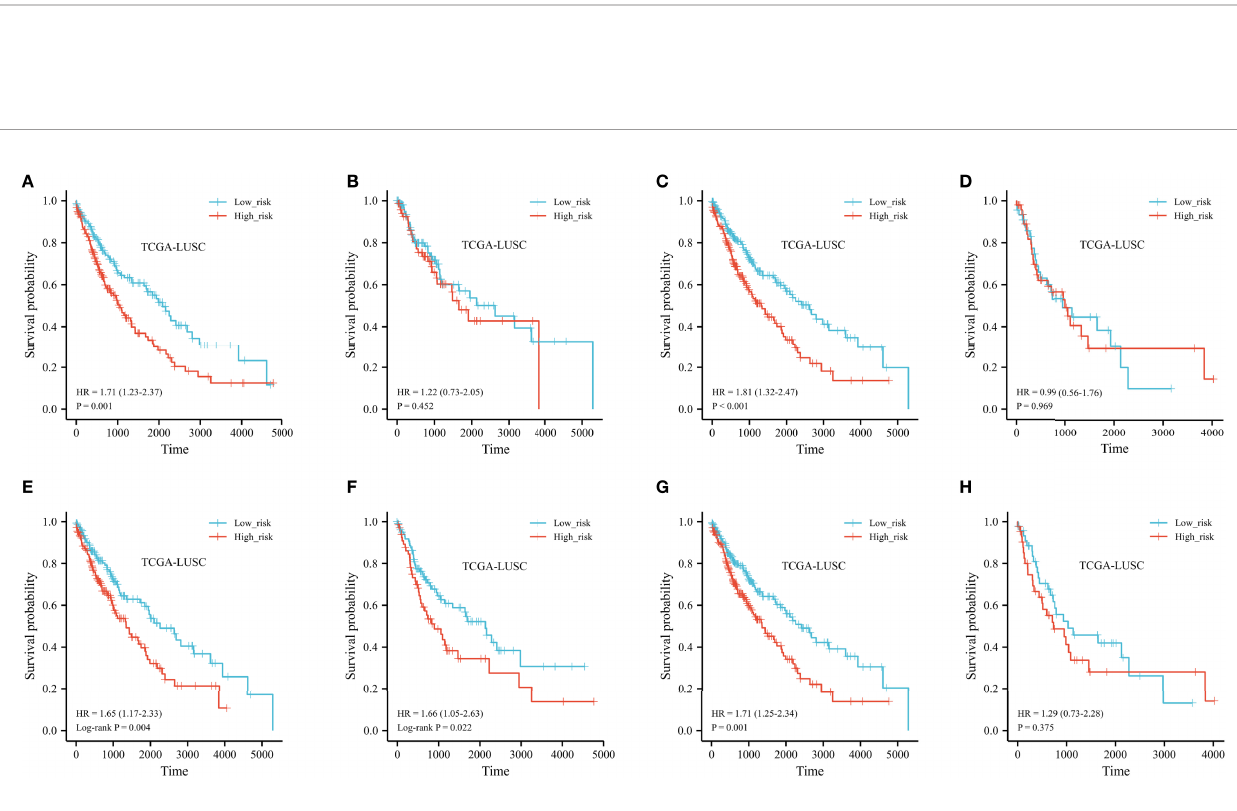
Frontiers in Oncology |